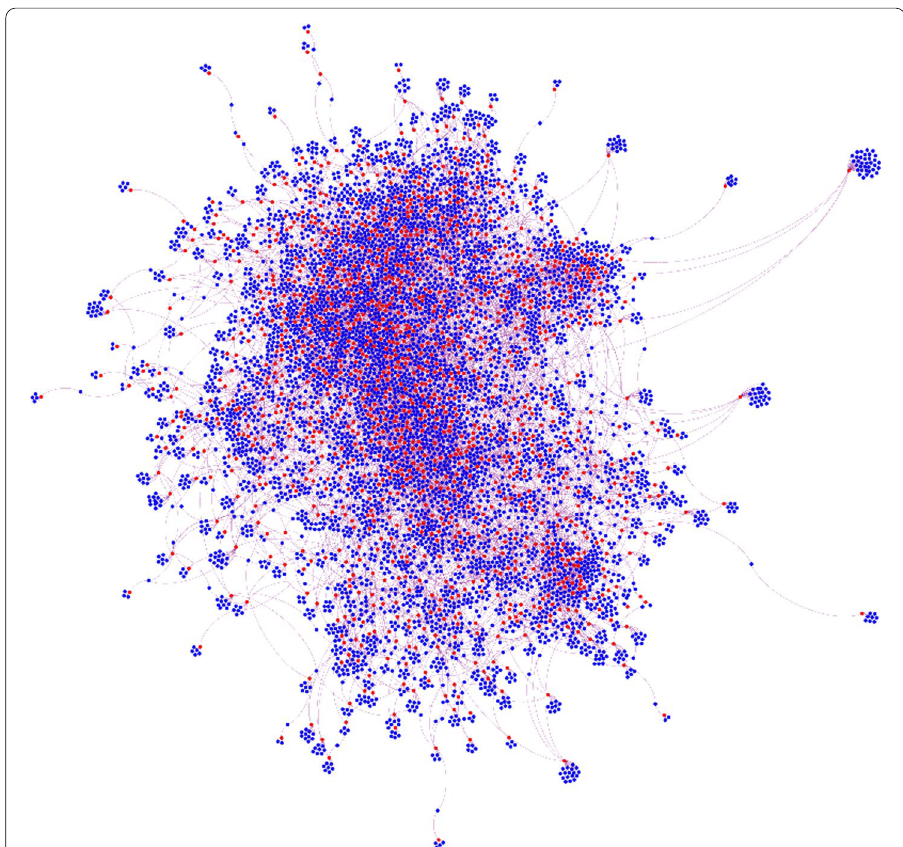
Fig. 2 Visualization of the AHDC co-location network. Adolescents are shown in red color nodes while the locations are shown in blue color nodes. An edge represents a location visit by an adolescent. Here, edge is